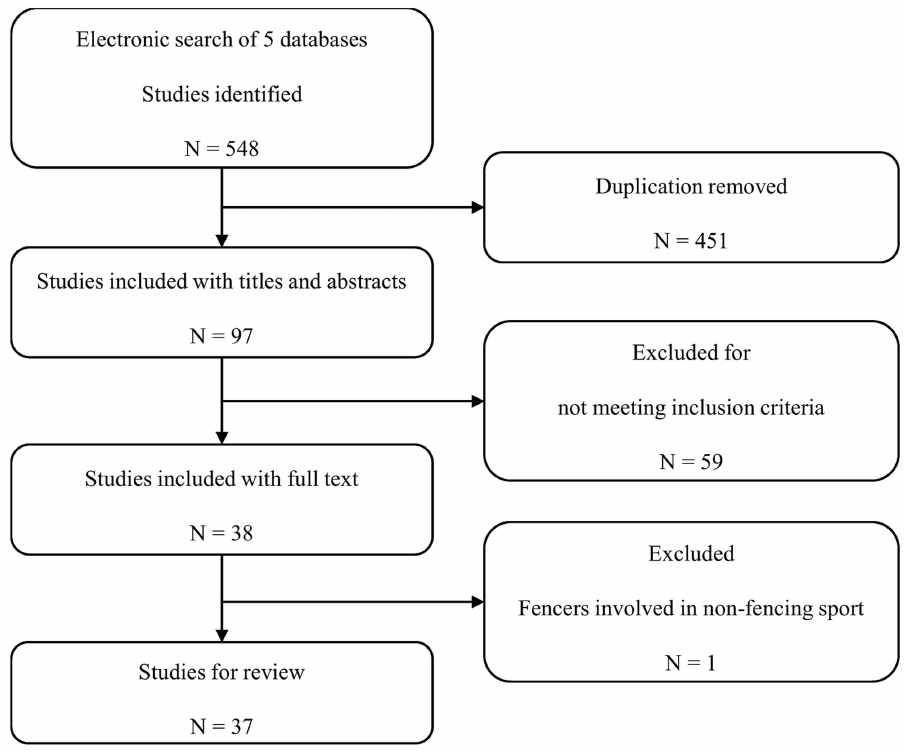
Fig 1. Flow diagram of the search strategy and screening of identified research for inclusion.